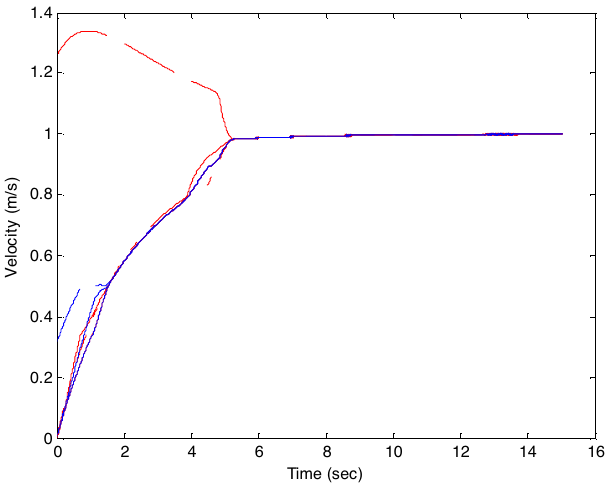
Figure 9. Consensus control on velocity of seven agents with attacks at one second interval.